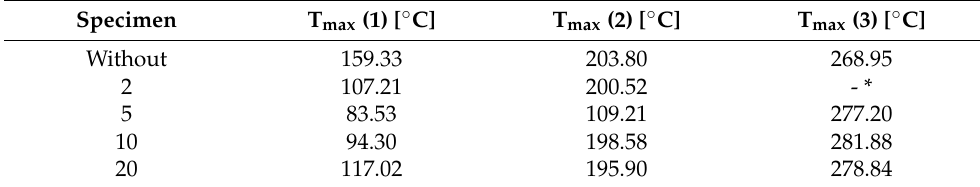
Table 1. The results of DTA analysis with temperatures of maximum peaks